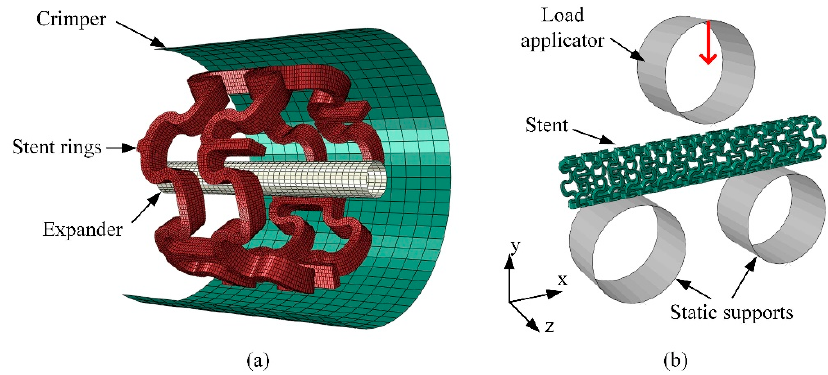
Figure 4. 3-D finite element (FE) models for ( a ) deformation tests and ( b ) three-point bending tests. The crimping and expanding of the stents were simulated, based on the model for the deformation tests, as shown in Figure 4a. Considering repeated stent rings in the axial direction, the model for the deformation tests was built by taking two adjacent rings out of the whole stent. The two rings of Stent A had a length of 1.81 mm and those of Stents B and C had lengths of 4.12 and 2.06 mm, respectively (Figure 1). The stents had the same outside diameter of 3.2 mm and a wall thickness of 0.335 mm. The material properties of the AE21 alloy given in Section 2.1 were adopted. The stent rings were fixed at one end in the axial direction, whilst the other end was left free. The straight lines (SL) were free only in the axial direction. The crimper and expander were represented by cylindrical surfaces and were controlled by a given radial displacement to force the stent rings to shrink and expand. Surface-to-surface contact models between the stent and rigid surfaces were built and a friction coefficient of 0.15 was set. The following four steps were taken and the displacement boundary conditions that decided the diameter changes of the stents were set based on experimental results.